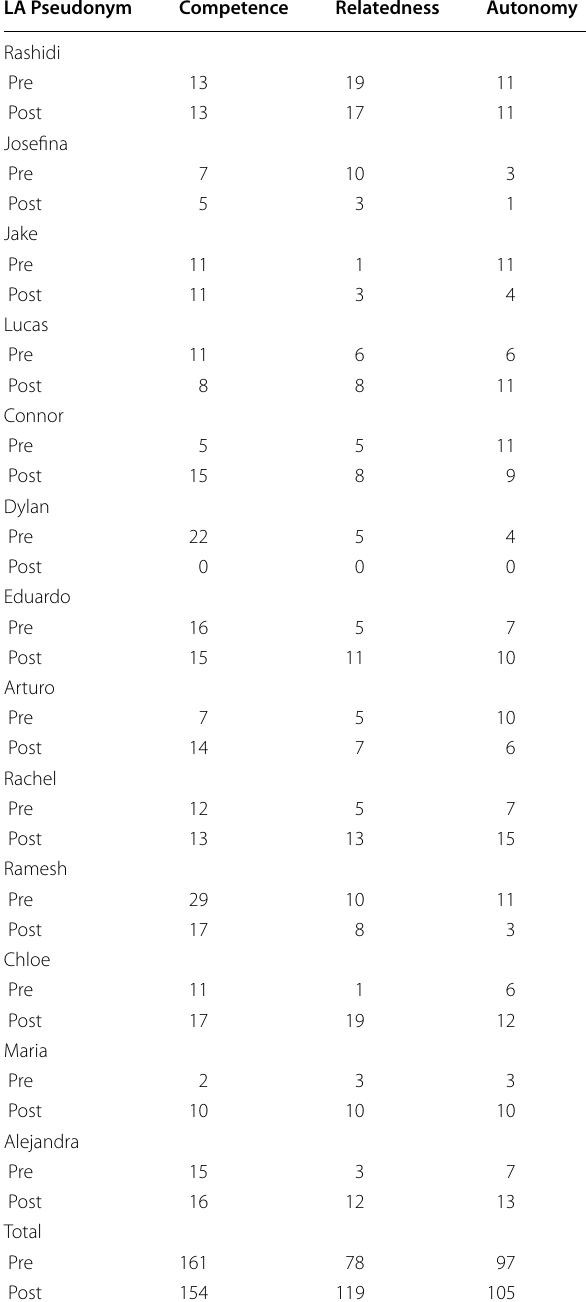
Table 5 Frequency count of learning assistant reflections related to the constructs of SDT before and after the remote